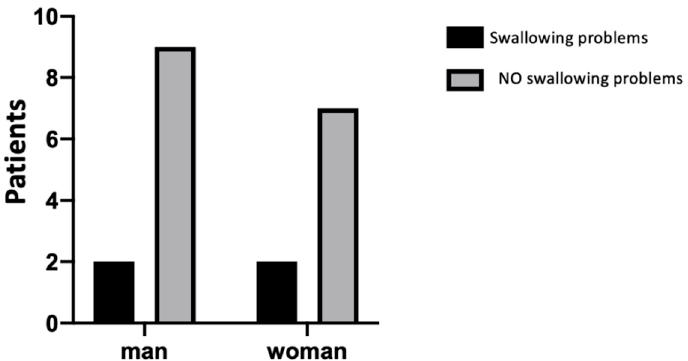
Figure A8. Difference between swallowing problems between males and females. No statistical significance ( p > 0.99) was shown between the sexes.